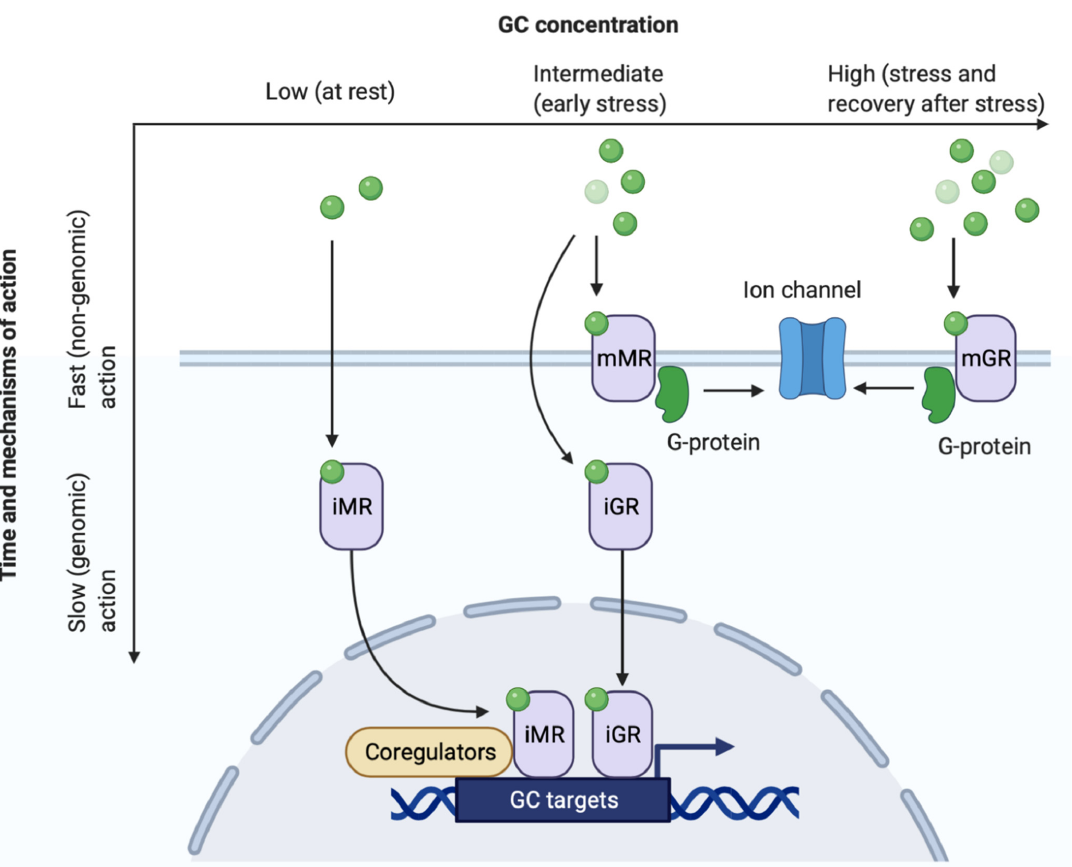
Figure 2. Receptors of glucocorticoids [29–31,83]. See details in Chapter 5. Green cir- cles—glucocorticoid